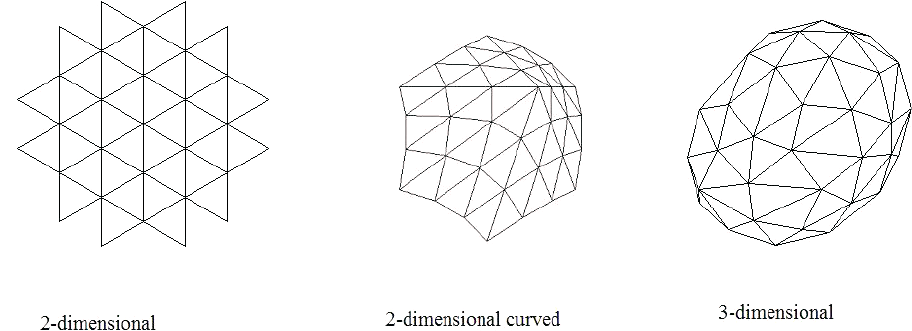
Fig. 2. Elements of spacetime of causal dynamical triangulation.